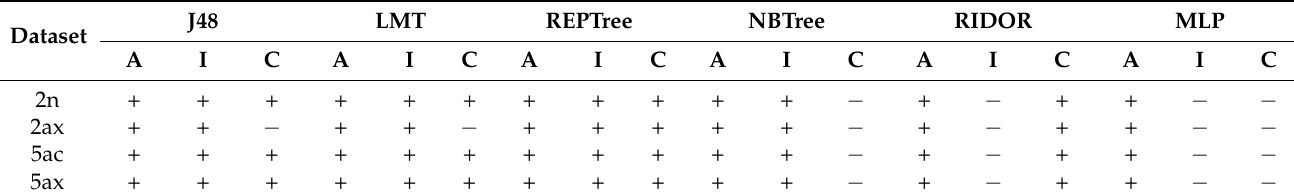
Table 3. Overall assessment of ML algorithms with respect to accuracy (A), interpretability (I), and computational cost (C)